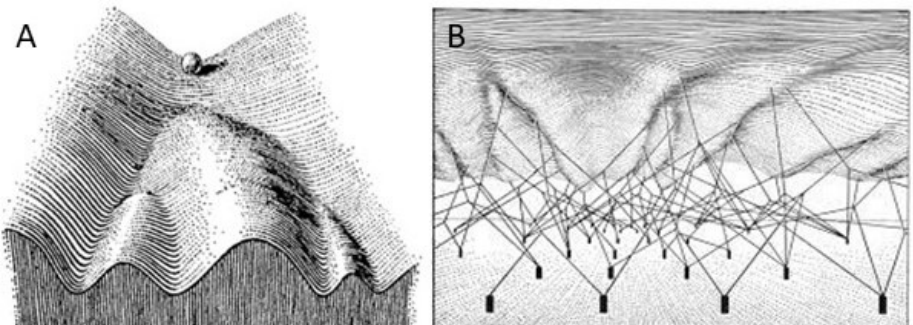
Figure 2. Waddington’s epigenetic landscape. Waddington’s epigenetic landscape ( A ) depicts the various potential routes via which a cell (Waddington: “part of the egg”) can develop as a system of valleys down which a ball can roll. ( B ) Looking from below, the landscape is defined by a framework of epigenetic “chemical interactions” emanating from fixed anchor points that represent the genes. Reprinted with permission from Ref. [15]. 1957, Taylor and Francis, London.